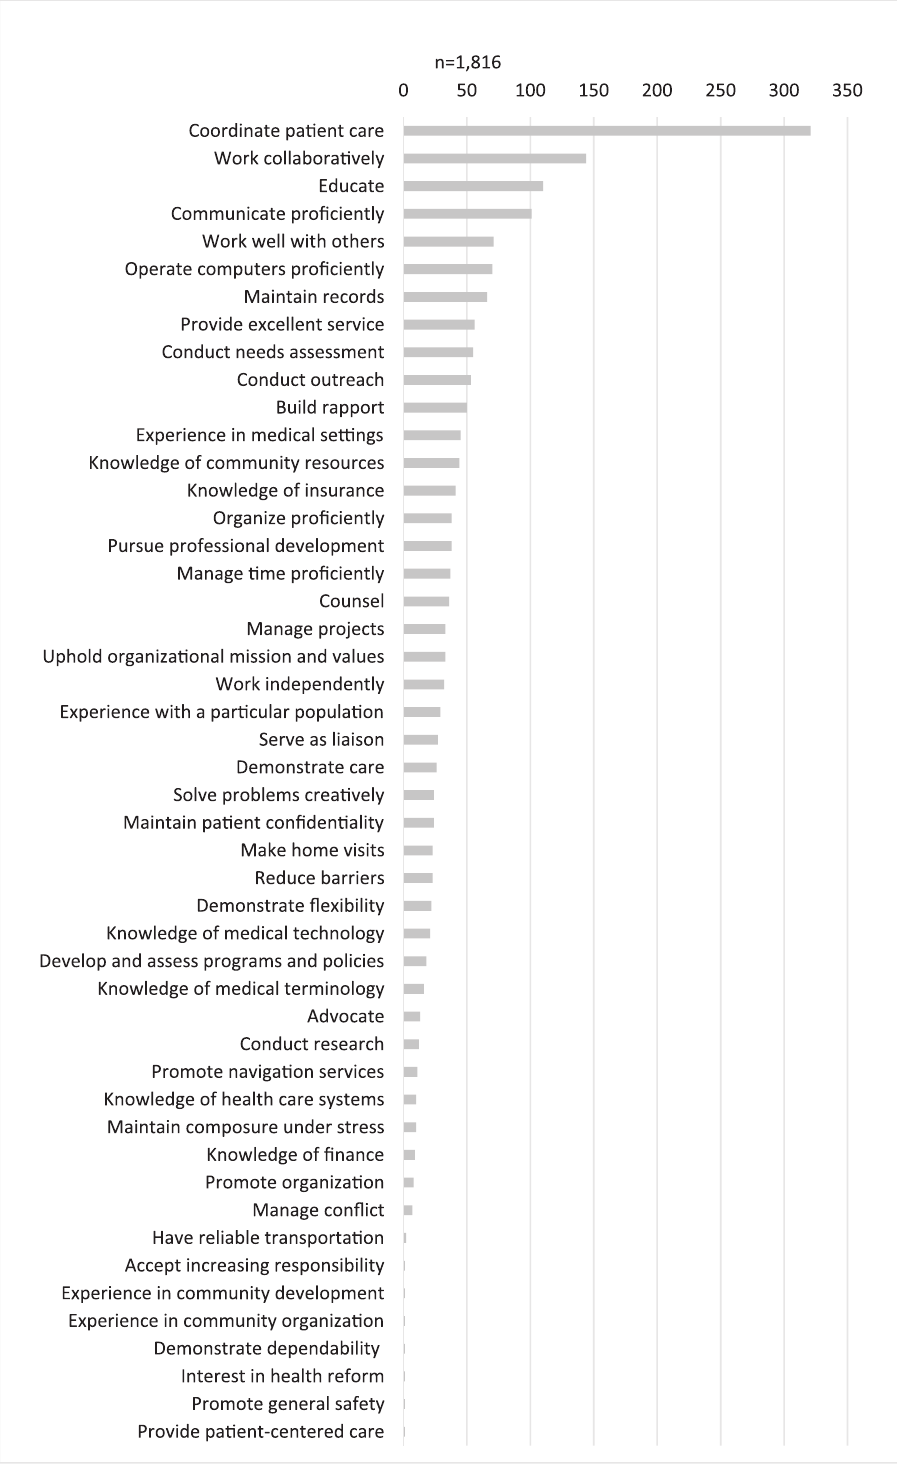
Navigator roles and skill